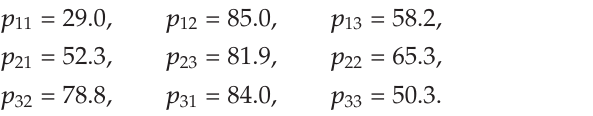
algorithm PSO-SA (cid:6) 37 (cid:7) and a rule-based genetic algorithm (cid:2) RBGA (cid:3) which uses the same dispatching rules for encoding but adopts classical crossover and mutation operators.